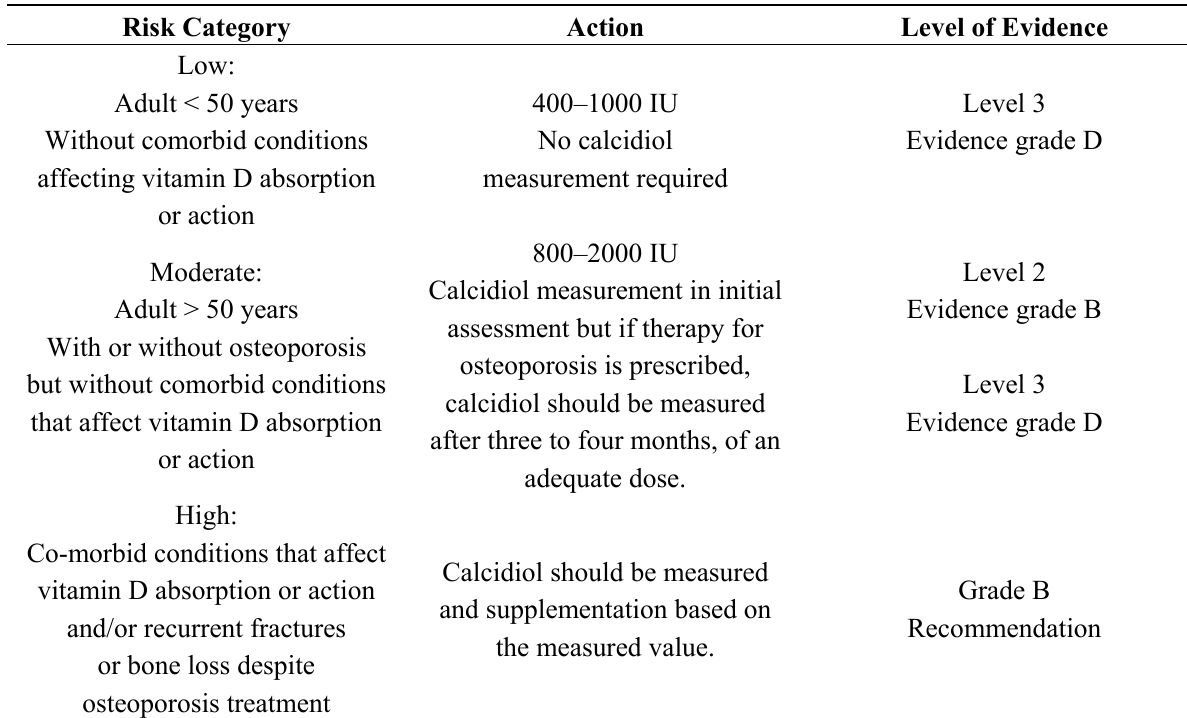
Table 5. Approach to vitamin D correction